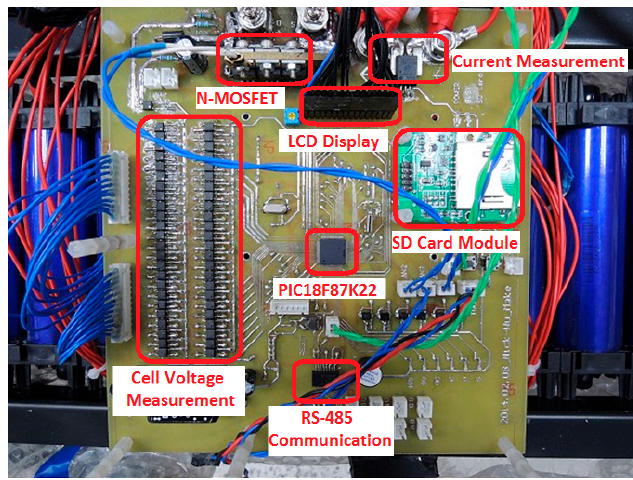
Figure 5. 72 V main control subsystem.